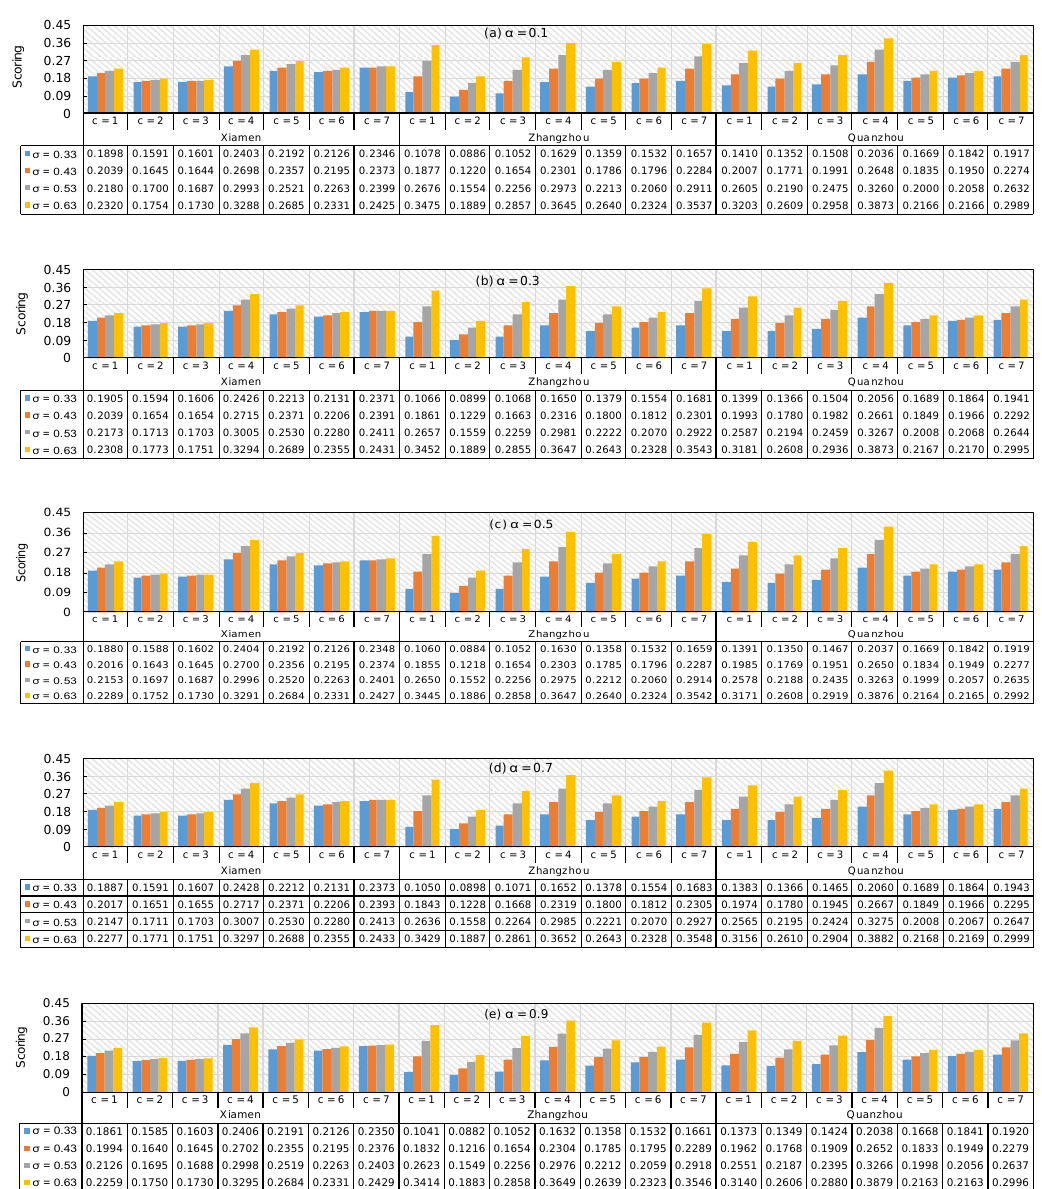
Figure 10. Integrated scoring for the planning policy: ( a ) α = 0.1, ( b ) α = 0.3, ( c ) α = 0.5, ( d ) α = 0.7, ( e ) α =